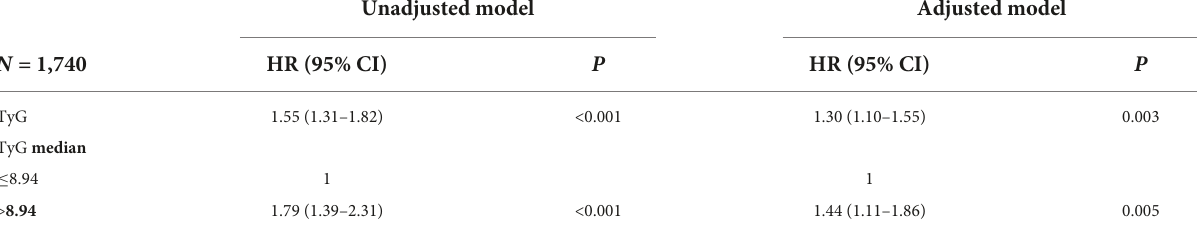
TABLE 3 Sensitivity analyses after excluding patients with follow up less than 12